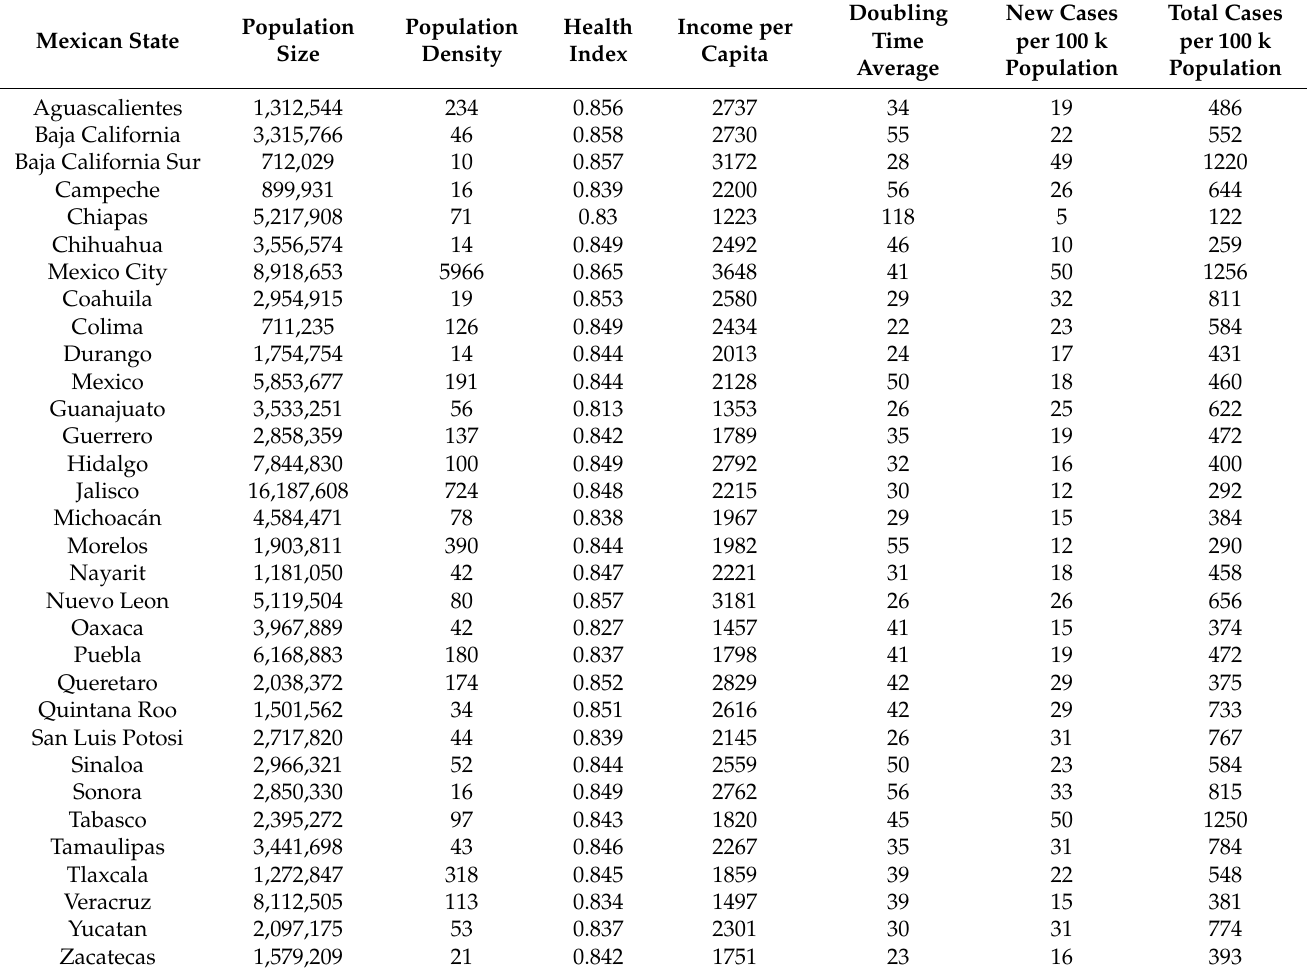
Table 2. Sociodemographic characteristics and doubling time by Mexican